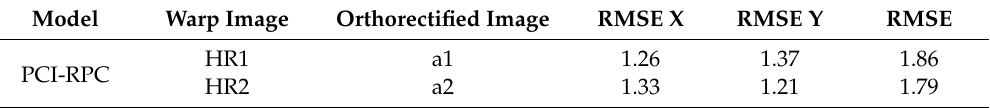
Table 1. A summary of residual errors of GCPs for orthorectified images a1/a2 (unit: meter)